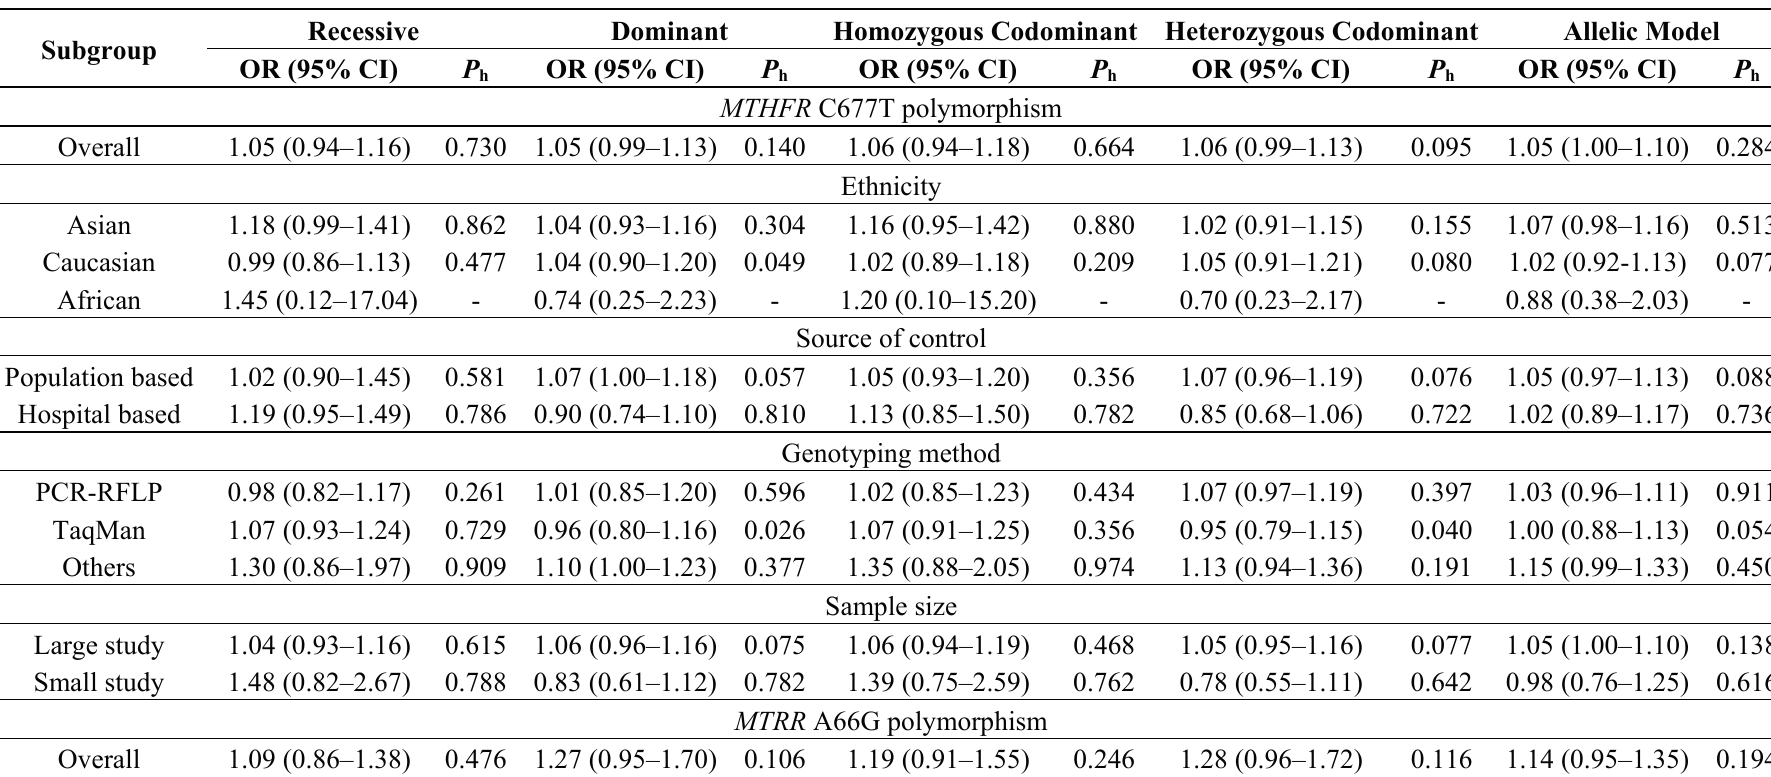
Table 4. Stratified analysis of the associations of MTHFR C677T and MTRR A66G polymorphisms with being overweight/obesity.